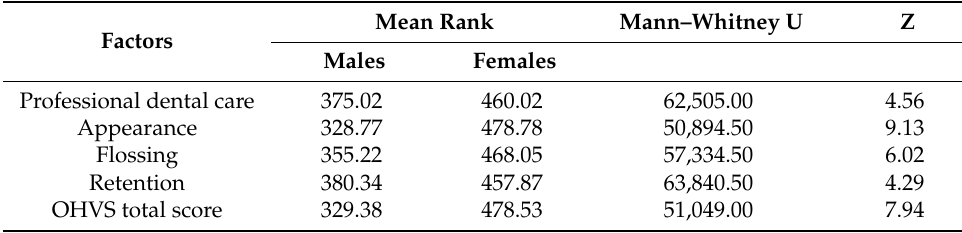
Table 6. The effect of gender